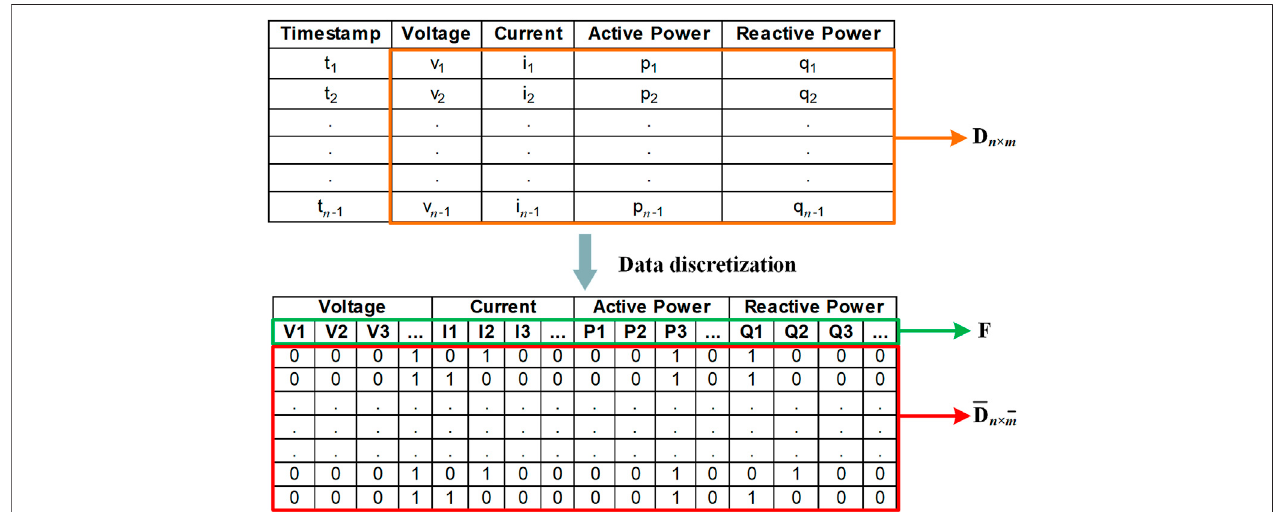
FIGURE 4 | The process of data discretization.